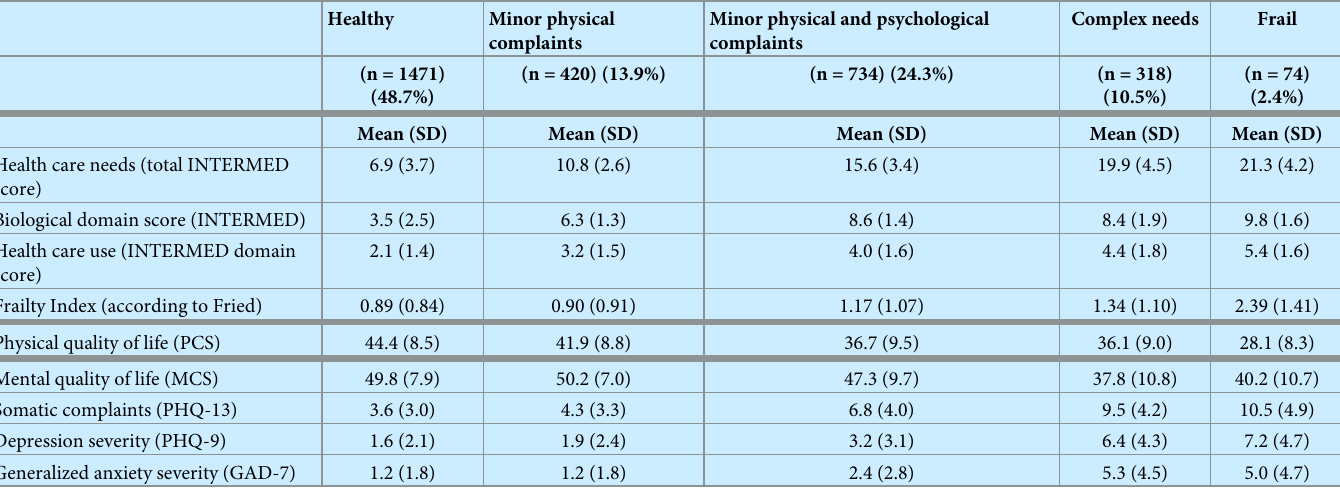
Table 2. Bio-psycho-social characteristics of the five clusters of elderly people.